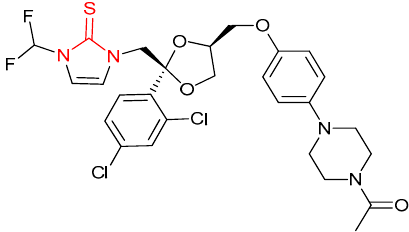
Figure 3. Ketoconazole thiourea derivative prepared by Tang and co-workers